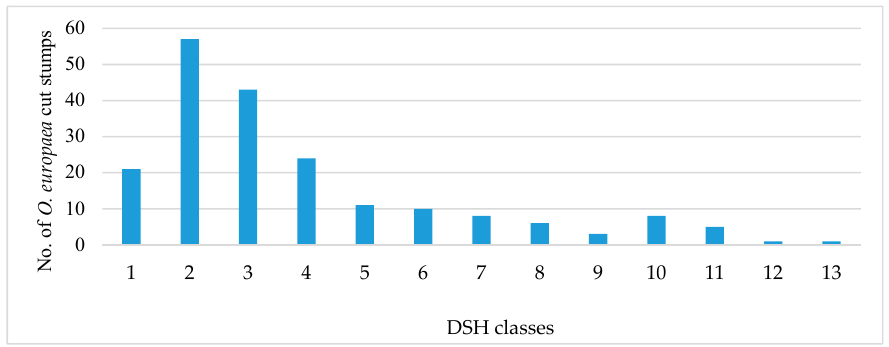
Figure 2. Number of Olea europaea (Wall. ex G. Don) Cif. stumps in different diameter classes in Hugumburda Forest. DHS class 1 = 0–2.9 cm; 2 = 3–5.9 cm; 3 = 6–8.9 cm; 4 = 9–11.9 cm; 5 = 12–14.9 cm; 6 = 13–17.9 cm; 7 = 18–20.9 cm; 8 = 21–23.9 cm; 9 = 24–26.9 cm; 10 = 27–29.9 cm; 11 = 30–32.9